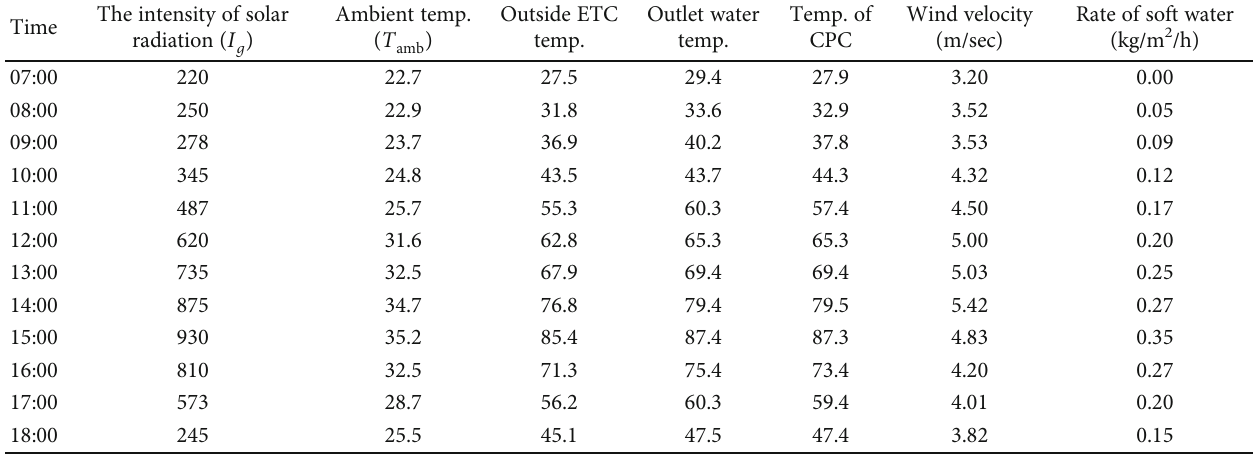
Table 3: Hourly variations of measured parameters in May 2018 with re fl ective white paint of CPC.